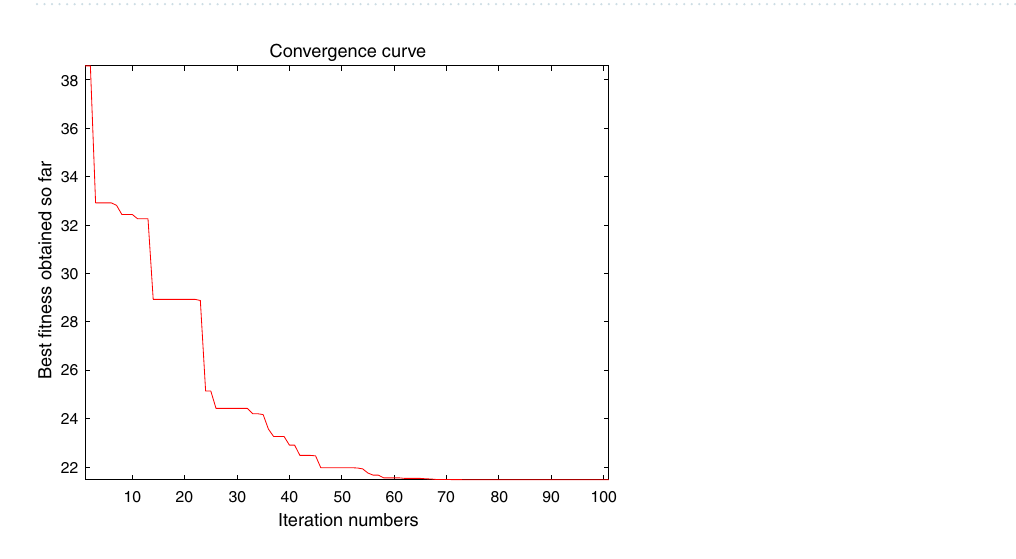
Figure 13. Convergence curve for car side impact